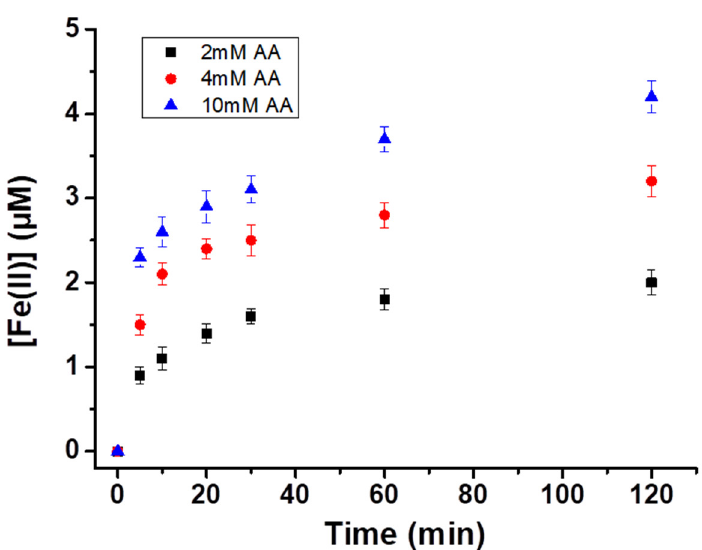
Figure 5. Evolution of Fe(II) concentration in the solution against time using various concentrations of ascorbic acid (2, 4, and 10 mM) in the presence of 0.5 g L − 1 magnetite and 20 mg L − 1 of PCP (total solution volume = 100 mL).